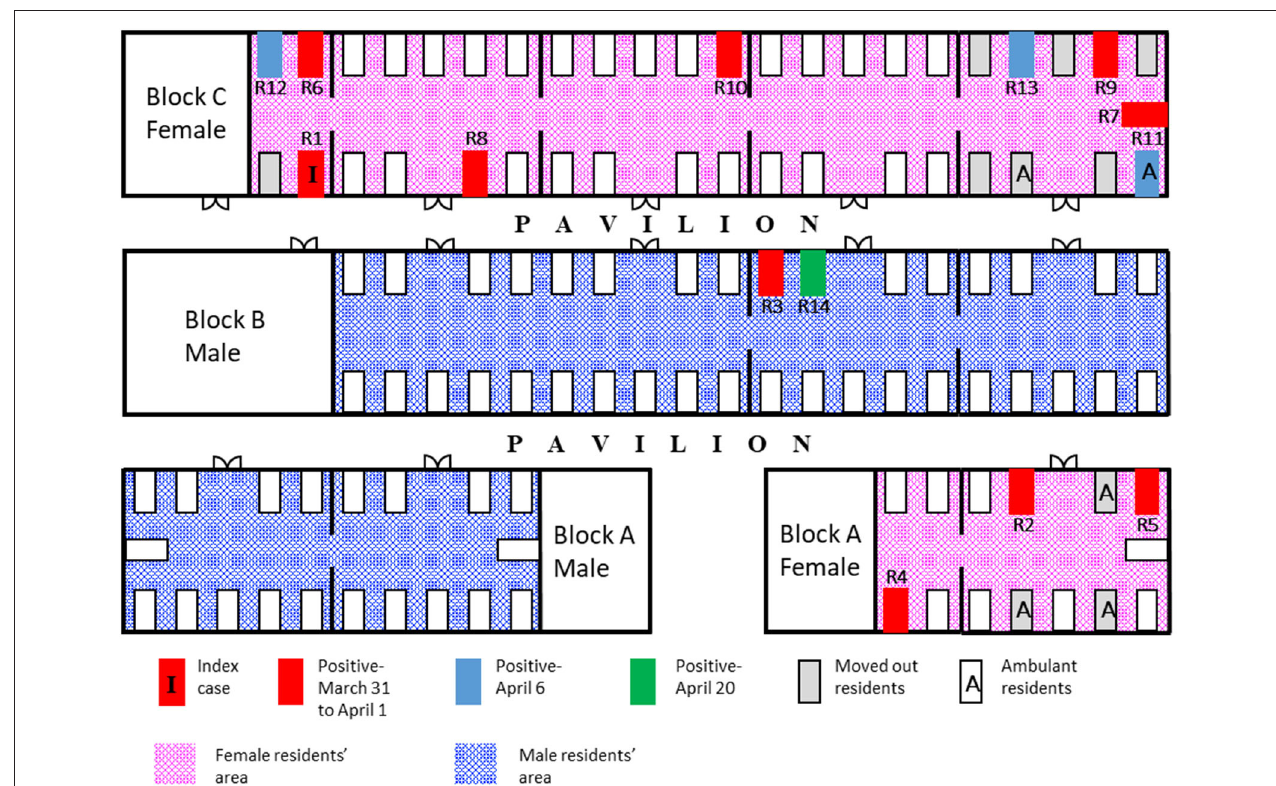
FIGURE 1 | Spot map of the facility. Schematic diagram of the facility (not drawn to scale) showing the spot map of infected cases and date of diagnosis; residents who were moved out of the facility on day 8 (April 7) of the outbreak.